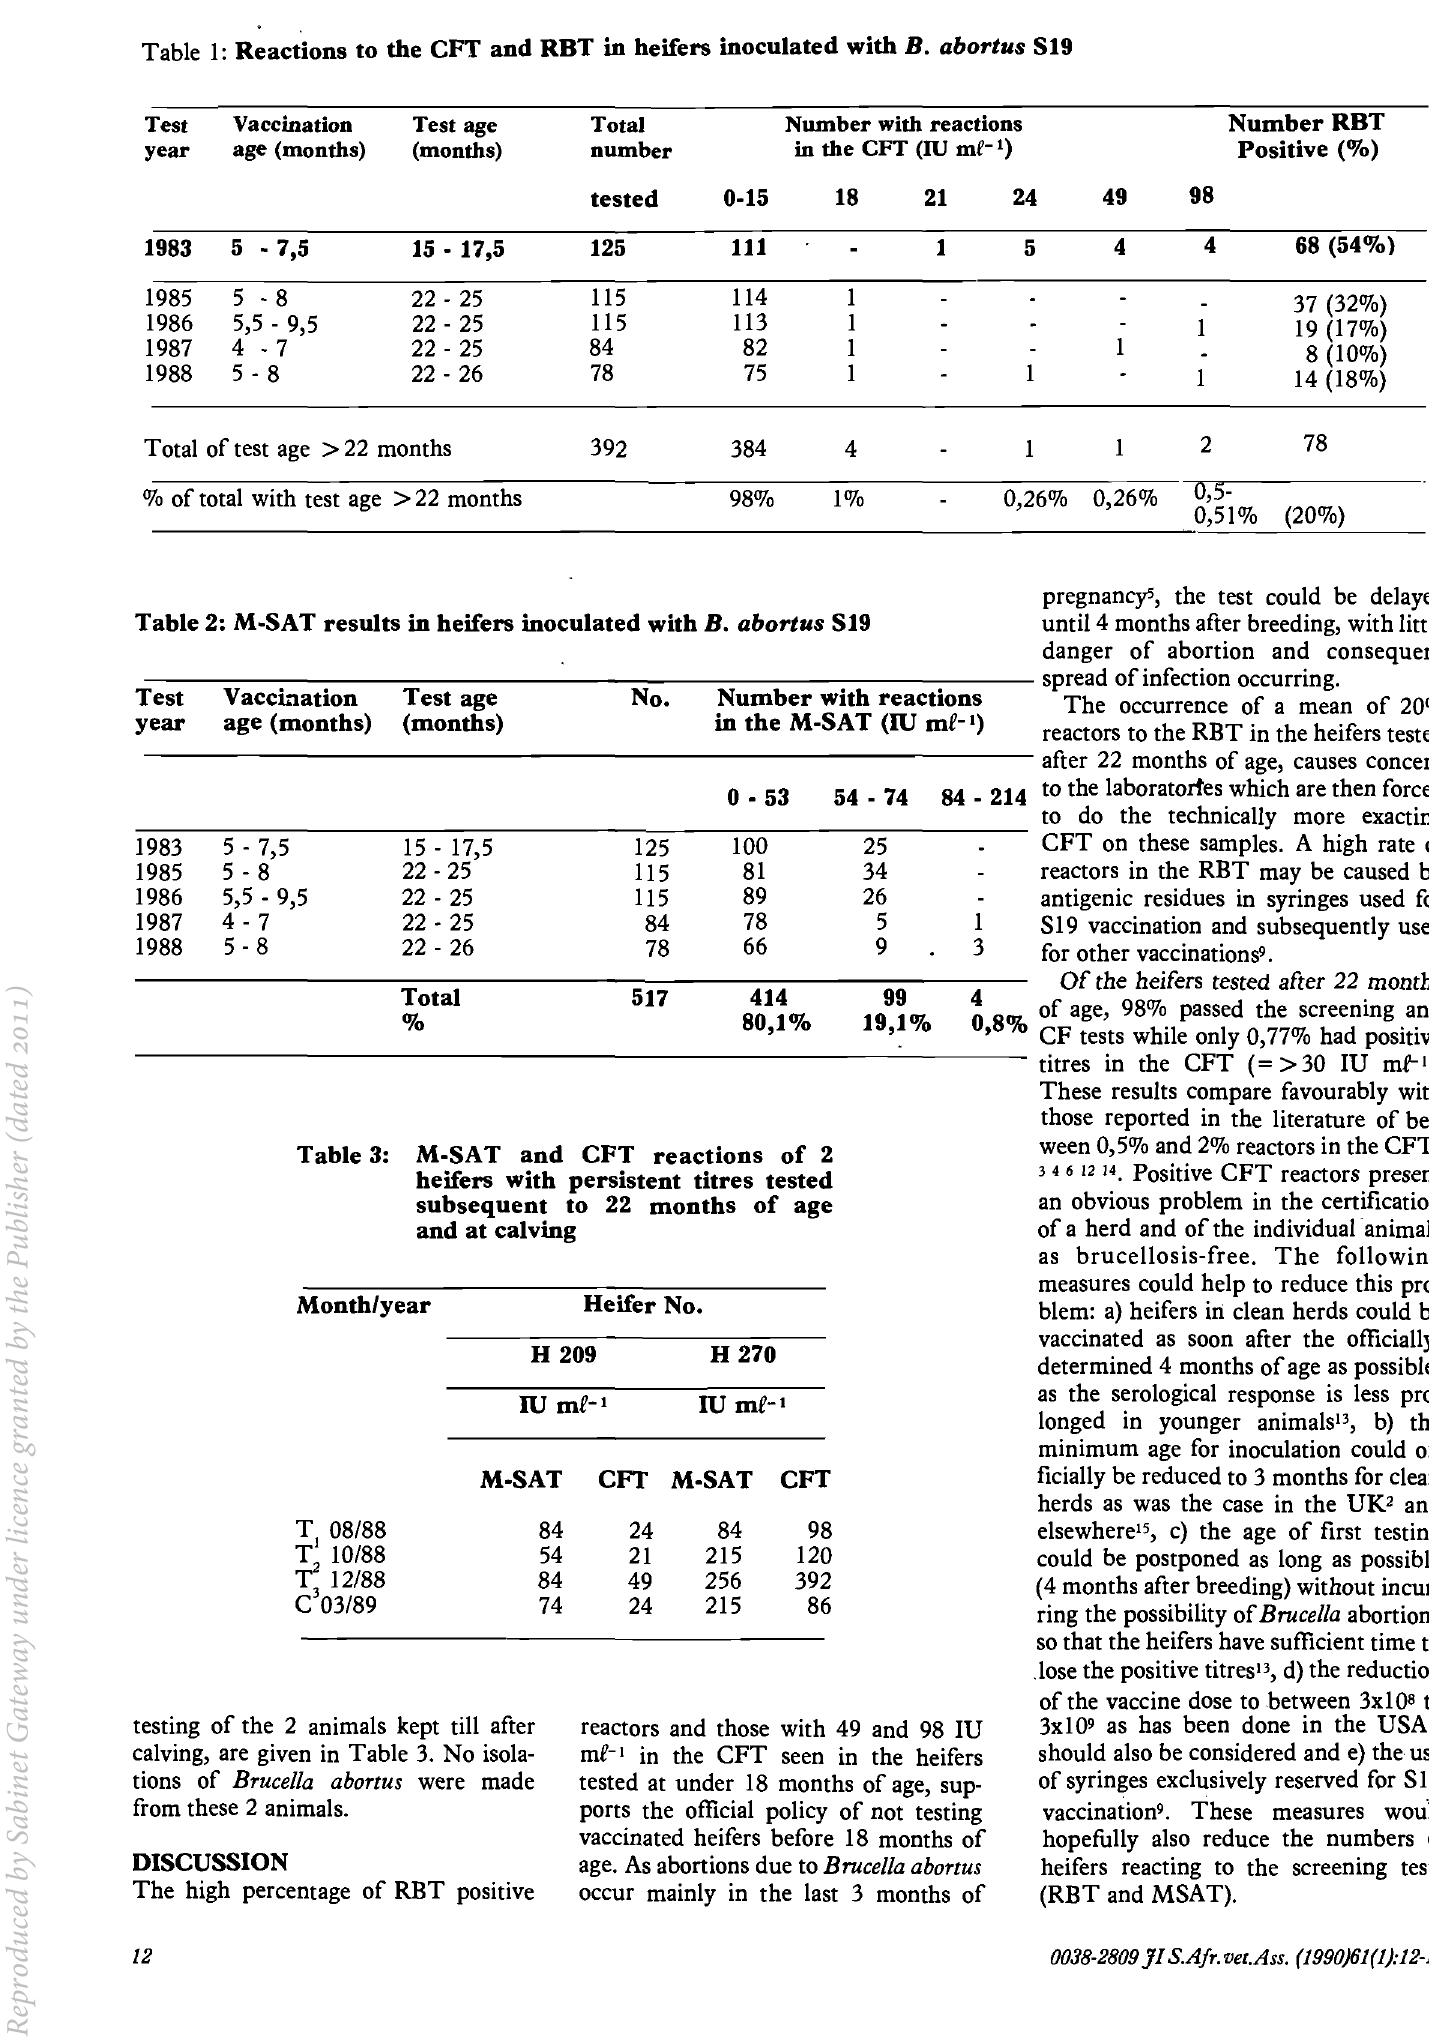
Table 2: M·SAT results in heifers inoculated with B. abortus S19